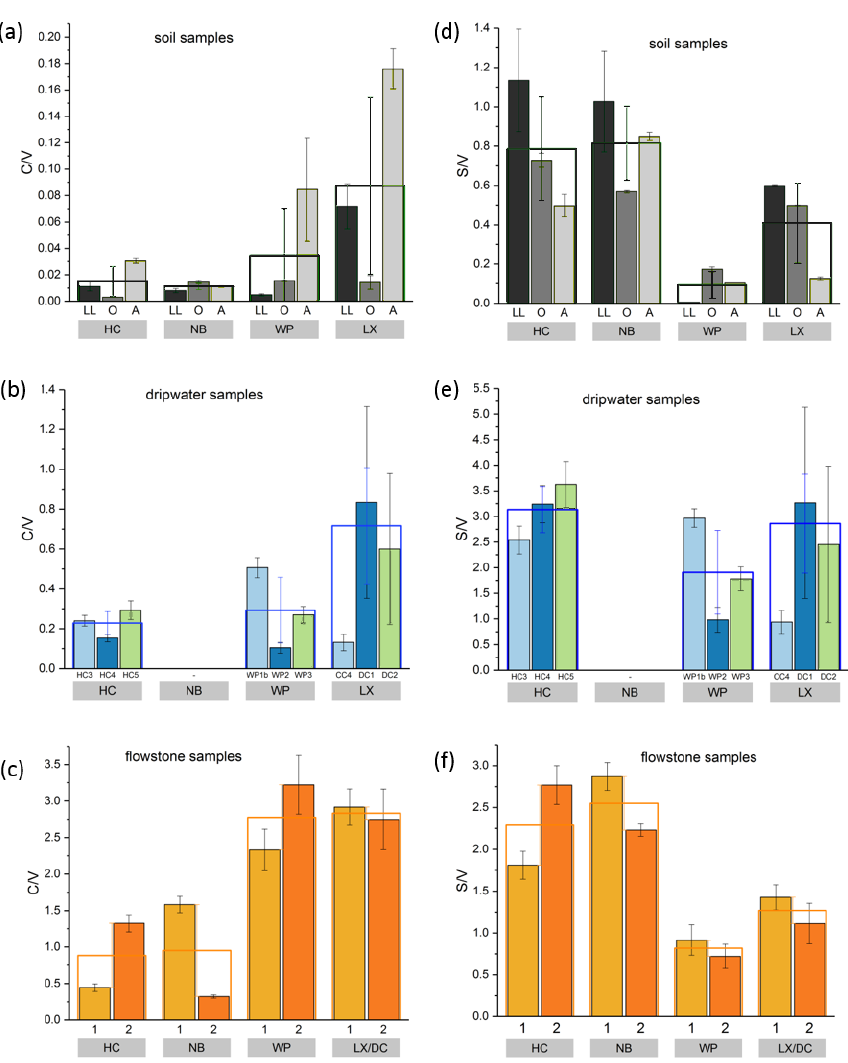
Figure 5. C / V and S / V values of the individual soil, dripwater and flowstone samples. The empty boxes show the mean values of the individual samples.